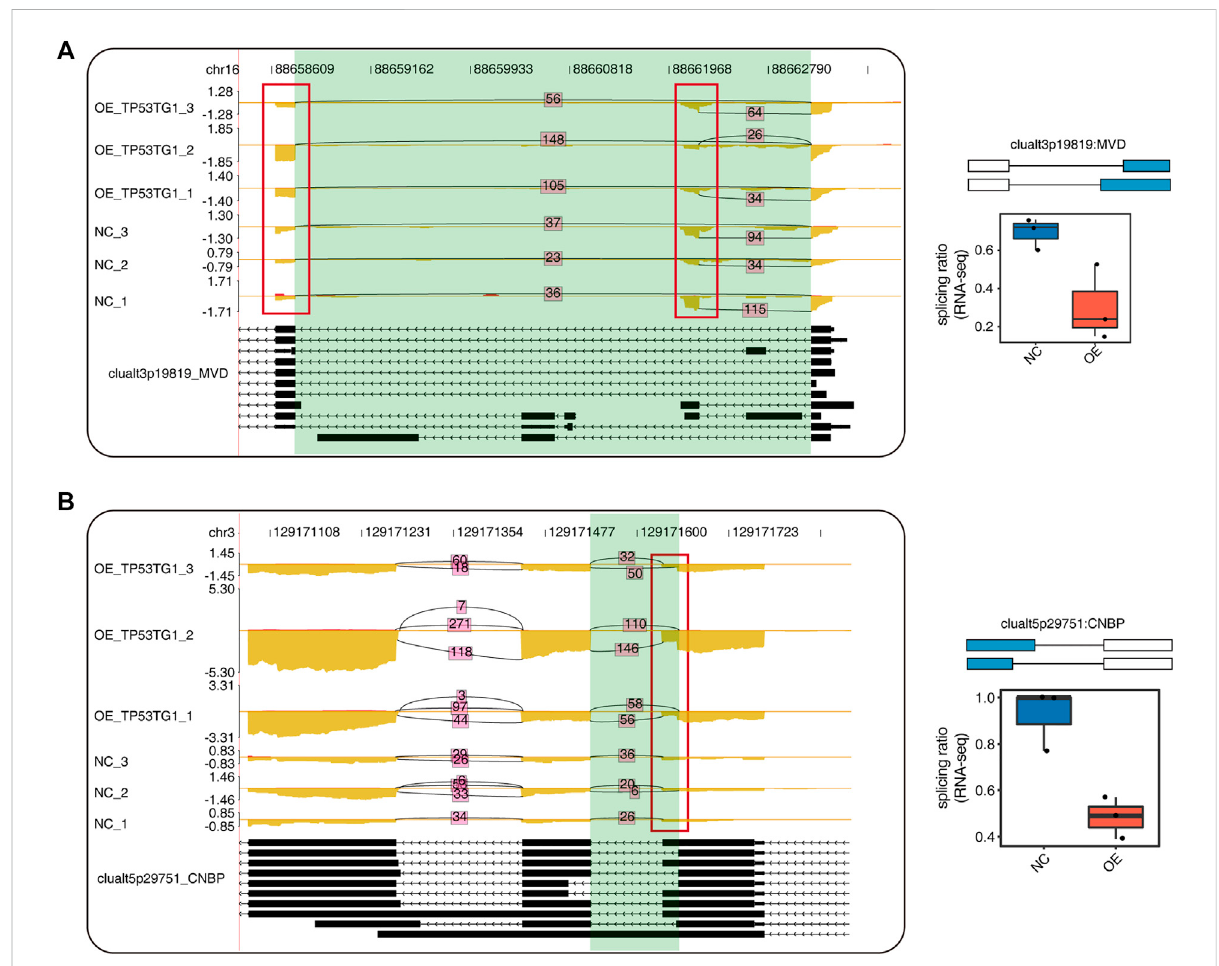
FIGURE 5 The Alternative splicing events which regulated by TP53TG1. (A) Visualization of junction reads distribution of clualt3p19819 RAS event located on MVD in samples from different groups. Splice junctions were labeled with SJ reads number. And altered splice site was marked out with red box. Splicing events model was shown in the right-up panel. Splicing ratio pro fi le of RNA-seq along with reverse transcription-qPCR validation in HeLa cells were shown in the right-bottom panel. (B) Visualization of junction reads distribution of clualt5p29751 RAS event located on CNBP in samples from different groups. Splice junctions were labeled with SJ reads number. And altered splice site was marked out with red box. Splicing events model was shown in the right-up panel. Splicing ratio pro fi le of RNA-seq in HeLa cells were shown in the right-bottom